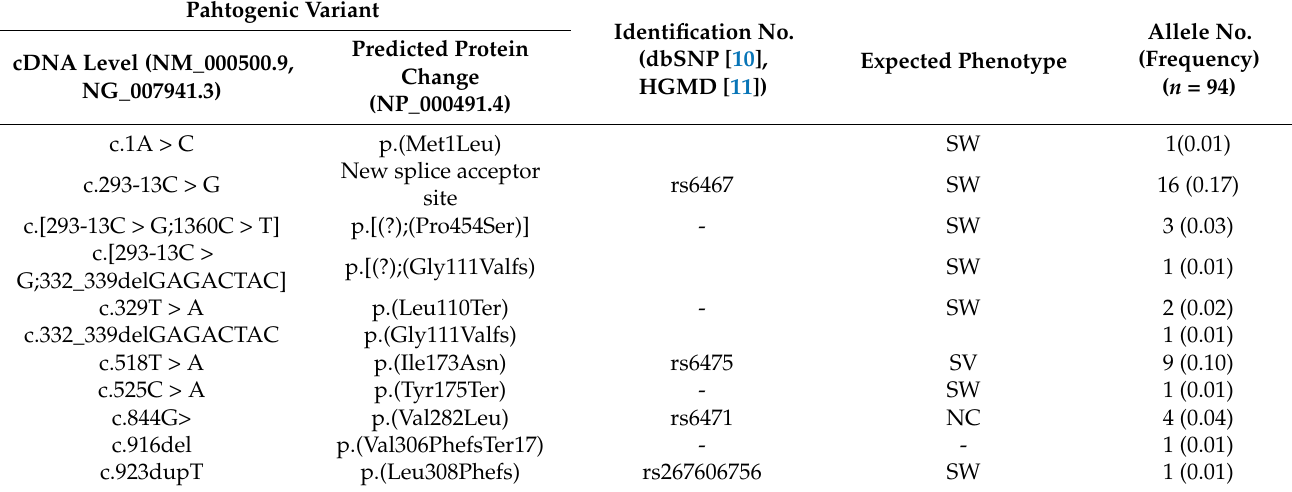
Table 4. CYP21A2 disease-causing variants detected in the Lithuanian patients